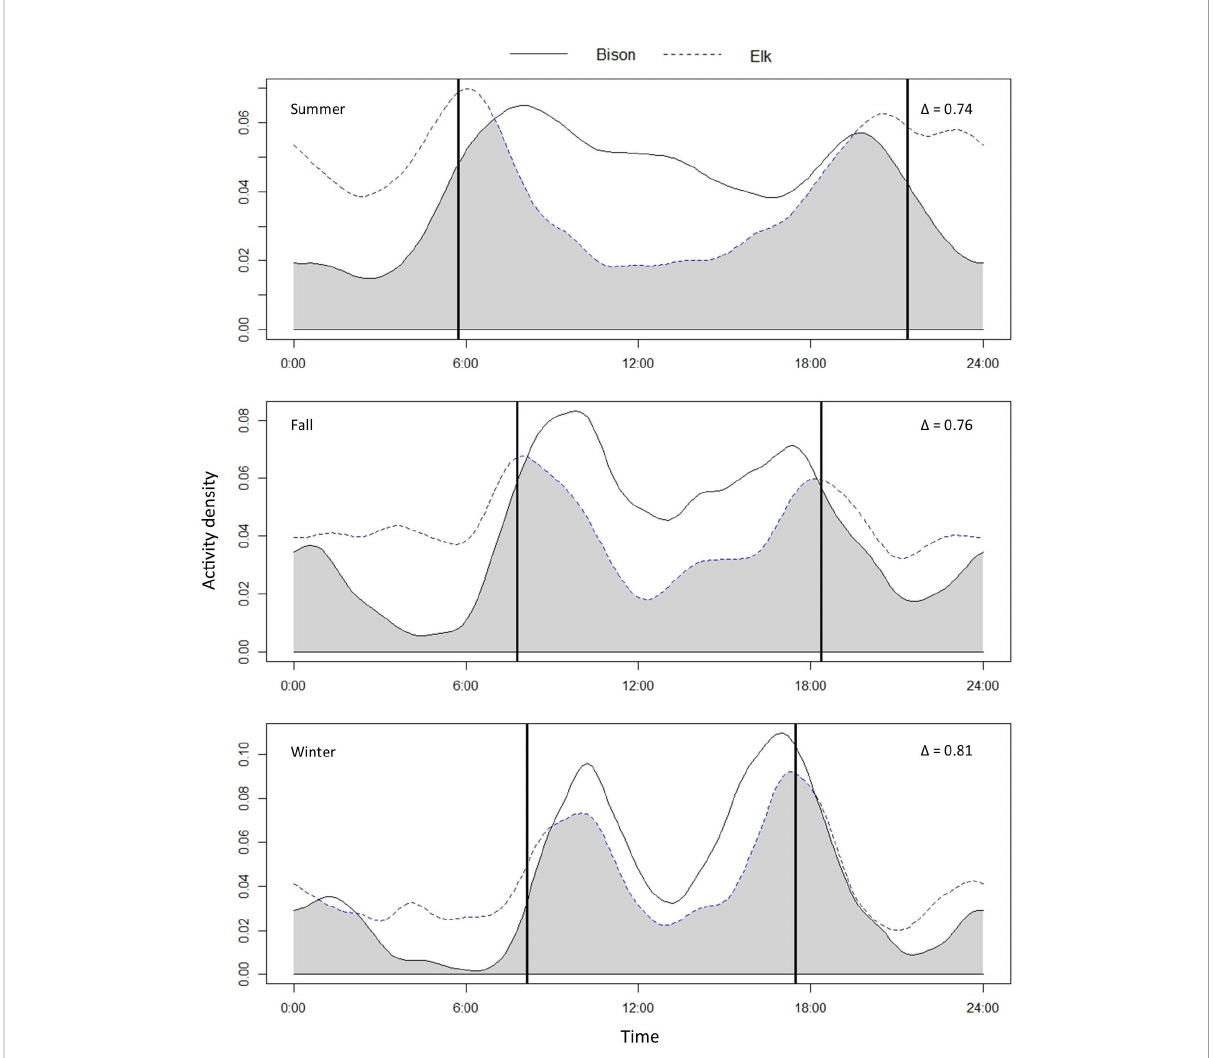
FIGURE 3 Activity patterns and coef fi cients of overlap of bison ( Bison bison ) and elk ( Cervus elaphus ) in summer (April-August), fall (September- November), and winter (December-March). Camera trap data were collected from 2016-2020 in Elk Island National Park in Alberta, Canada. The area of overlap is shaded in grey and D is the coef fi cient of overlap. The bold vertical lines show the time of sunrise and sunset based on seasonal